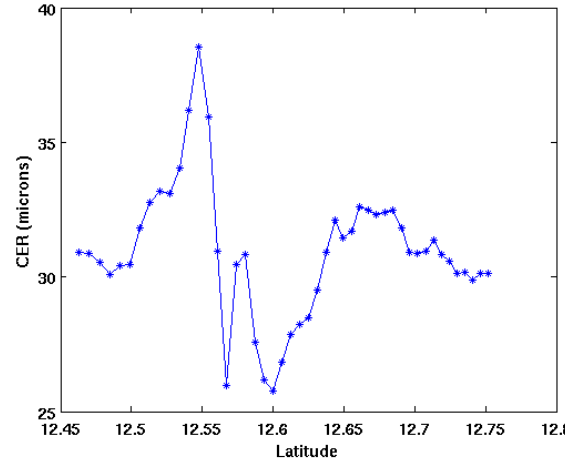
Figure 4. Distribution of MODIS derived CER along transect through the centre of the cyclone for 08 November 2015, 0735